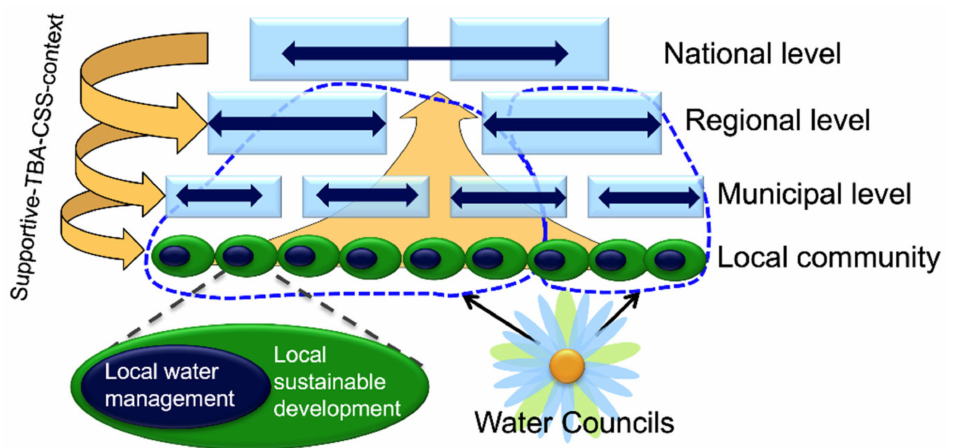
Figure 10. Local communities and collaborations as engines for sustainable development embedded in a multi-level governance setting. Source: